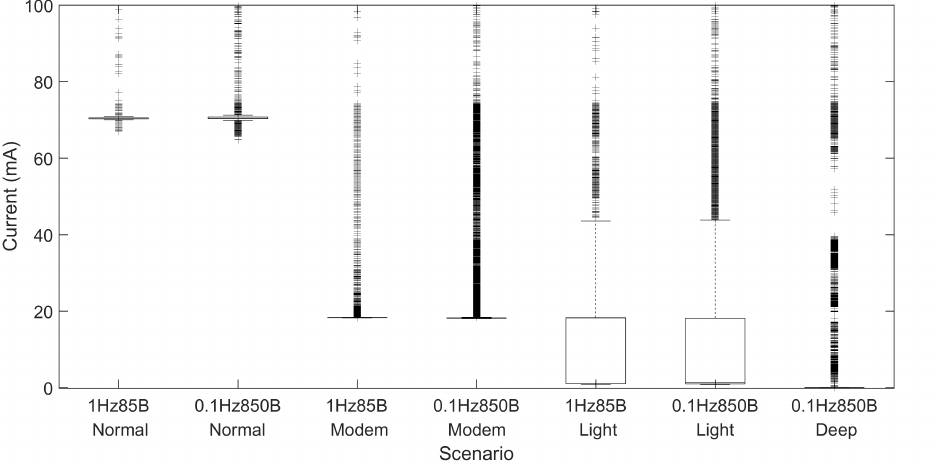
Figure 5. Module current measured in each test